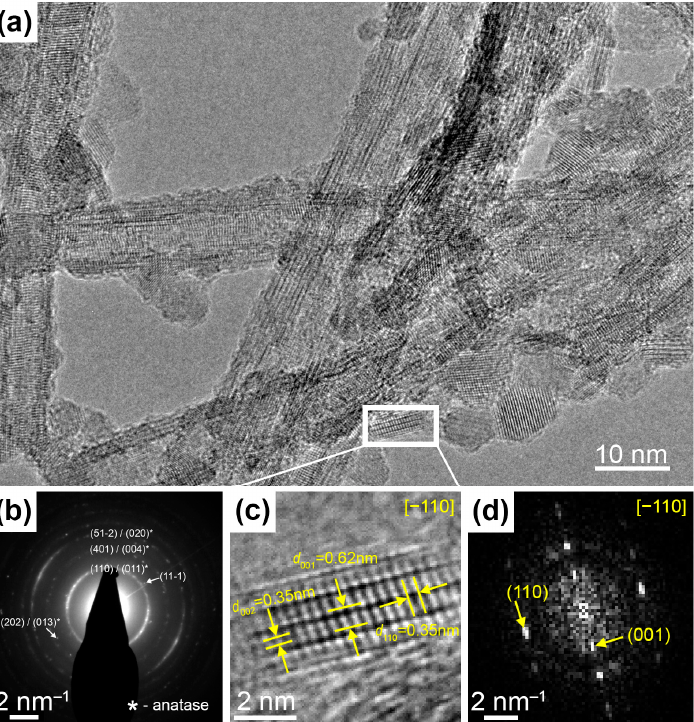
Figure 2. ( a ) HRTEM-image of several TiO 2 nanotubes. ( b ) The electron diffraction pattern identifying bronze titania. ( c ) The magnified region of HRTEM-image shows the nanocrystal oriented in [ − 110] zone axis and ( d ) the corresponding Fast Fourier Transform image.